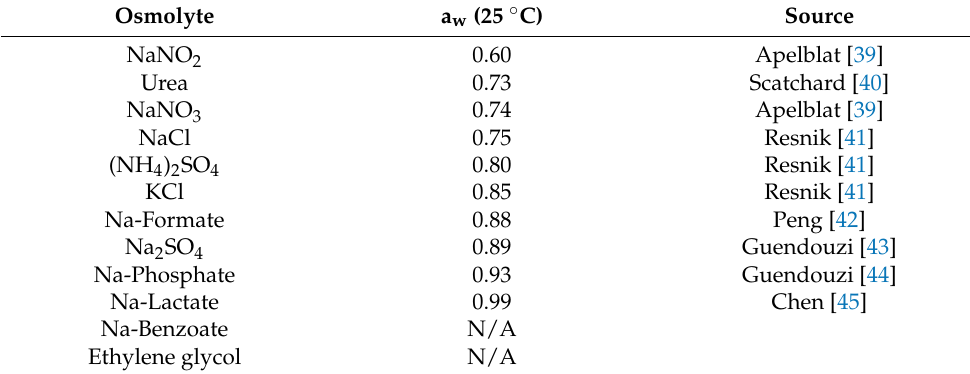
Table 6. Water activity (a w ) values for the tested osmolytes at 25 ◦ C. Lower values indicate a higher deviation from ideal water behavior in saturated solutions, and therefore higher osmotic tension. N/A—no data